Question: Write a single sentence explaining what this figure depicts.
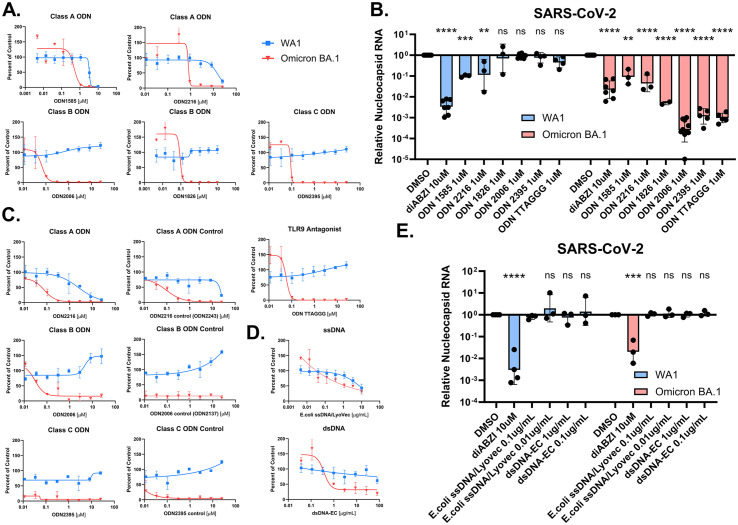
Answer: Diverse short oligodeoxynucleotides control SARS-CoV-2 infection. (A, C, D) Calu-3 cells were pre-treated with indicated compounds in 8-pt dose-response for 2h and infected with SARS-CoV-2 (MOI 0.5) WA1 ancestral strain (blue) or Omicron BA.1 (red) for 48h and processed for automated microscopy and image analysis quantifying total cell numbers and percent infection (dsRNA + /nuclei+) to quantify Percent-of-Control (POC) % positive. Each data point represents the mean ± SD of n = 2 biological replicates. (B,E) Calu-3 cells were pre-treated with vehicle (DMSO), diABZI positive control, or ODNs for 2h and infected with WA1 or BA.1 (MOI 0.2) for 48h and subject to RT-qPCR analysis of viral RNA (Nucleocapsid). Mean±SD with individual biological replicates shown. Significance was calculated using One Way ANOVA with Dunnett Correction on DMSO control (**p < 0.01, ***p < 0.001, ****p < 0.0001; ns, no significance).